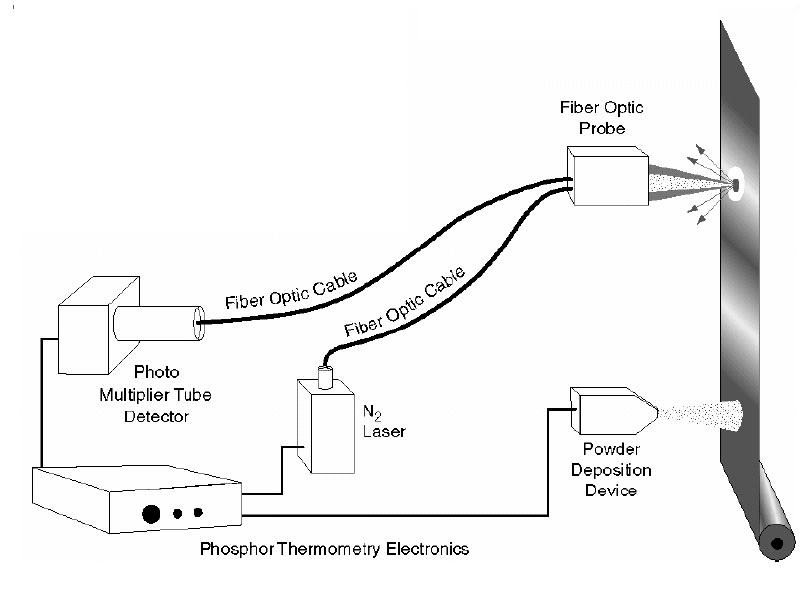
Figure 69. Schematic of the Galvanneal temperature measurement system